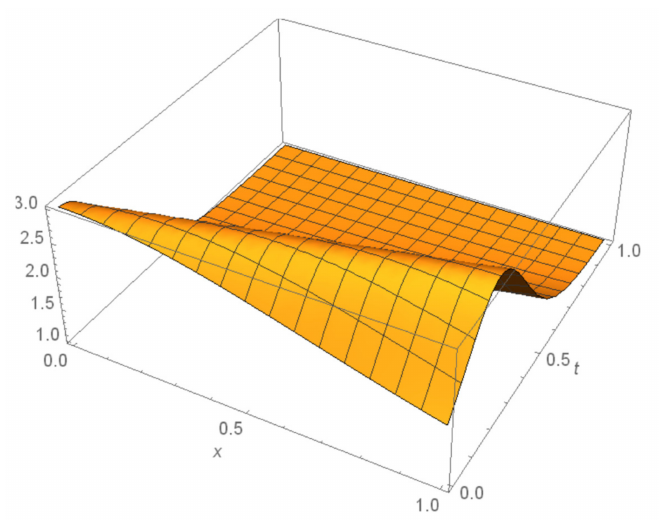
Figure 10. 3D plot of (cid:101) g at α =